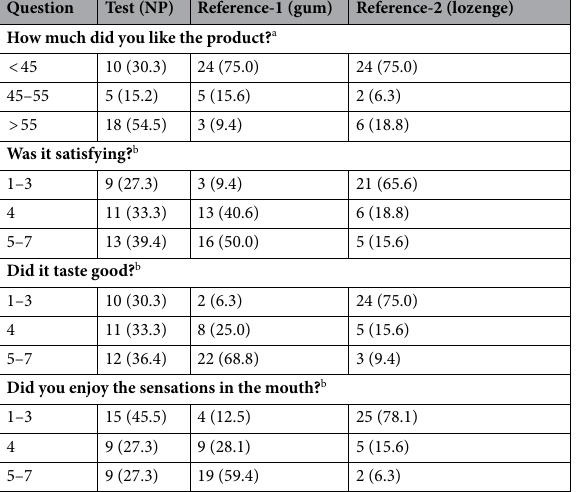
Table 4. Summary of subjective effects assessment. Data are presented as n (%). Number of subjects (denominator) = 33 for NP and 32 for gum and lozenge. a Original scale was from 0 (not at all) to 100 (extremely). b Original scale was from 1 (not at all) to 7